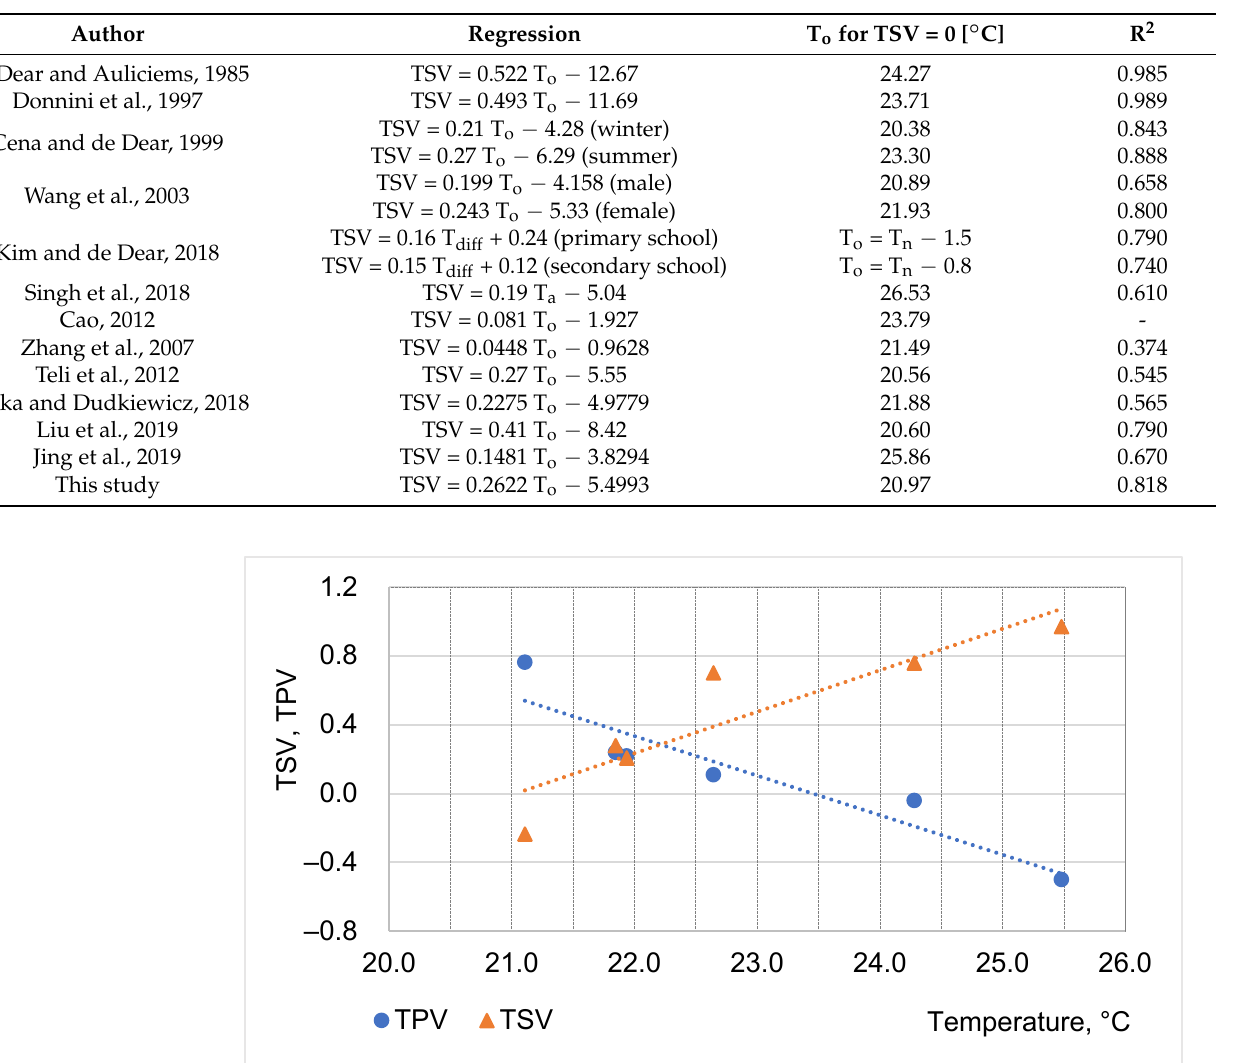
Table 6. Regression models of TSV from field studies done in classrooms [45–50].